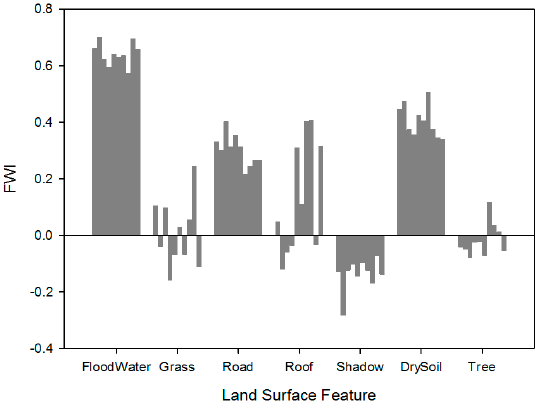
Figure 5. The FWI values of various land surface class samples from the aerial photo of site A (Note: the “road” class includes the parking lots).